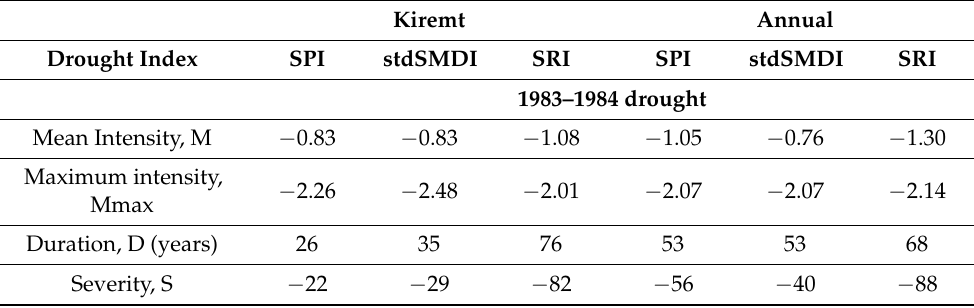
Table 5. Characteristics of the historic drought events as identified by the three drought indices computed using basin-wide average rainfall and soil moisture input data and flow data measured at the outlet of the